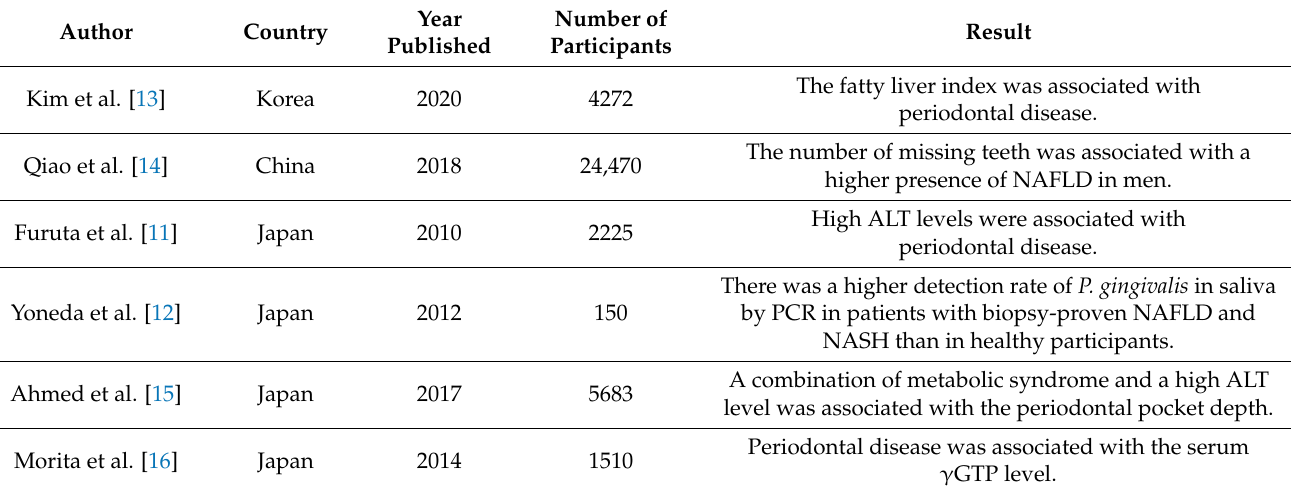
Table 1. Cross-sectional studies of periodontitis and